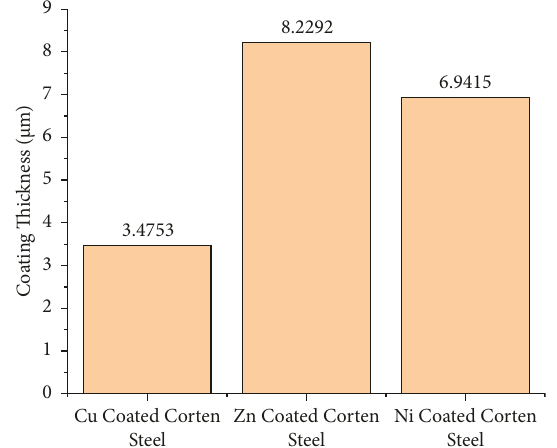
Figure 6: Roughness ( R a ) of electroplated corten steel.